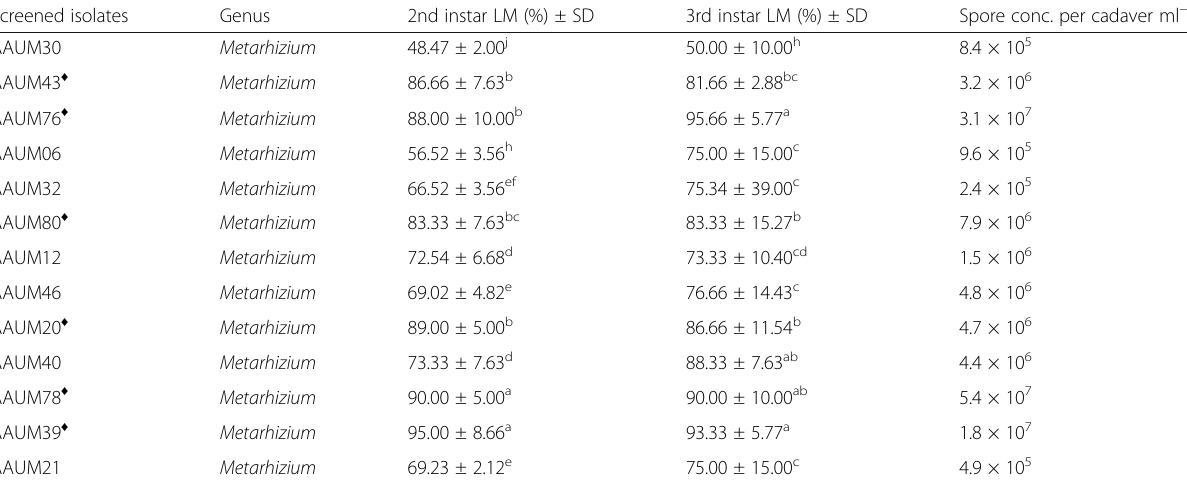
Table 2 Rescreening of pathogenically potential isolates against second and third larval instars of Tuta absoluta at 1 × 10 7 spore ml − 1 for 7 days exposure and sporulation potential over cadavers Screened